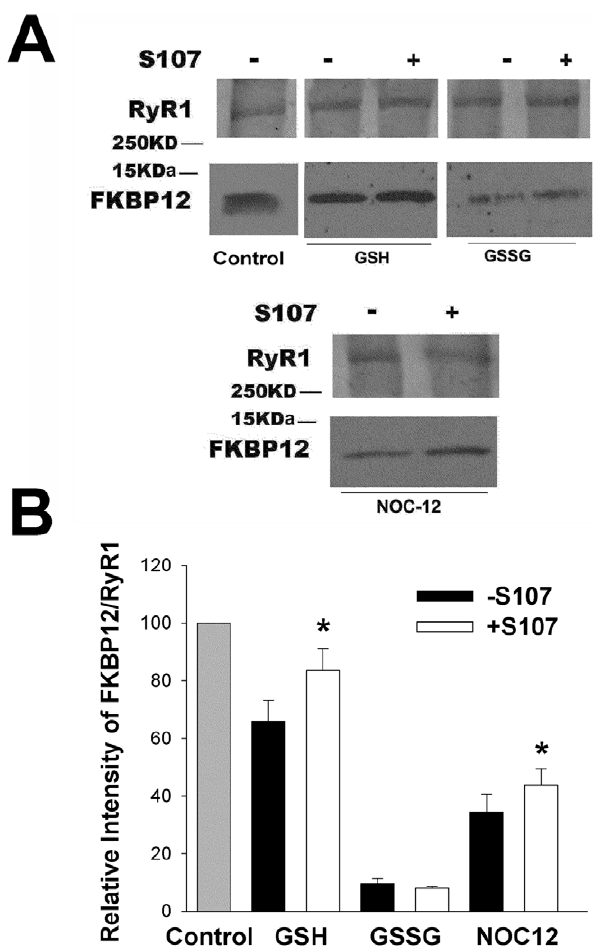
Figure 6. Effects of S107 on FKBP12 binding to RyR1. (A) Immunoblots of RyR1 and FKBP12. SR vesicles depleted of FKBP12 were incubated for 20 h at 24 u C in 0.25 M KCl, 20 mM imidazole, pH 7.0, 7 m M free Ca 2 + , protease inhibitors and 10 nM FKBP12 without or with 44 m M S107 in the absence and presence of 5 mM GSH, 5 mM GSSG or 0.10 mM NOC12. SR vesicles not treated with FK506 and incubated without glutathione served as control. (B) SR vesicles not treated with FK506 served as control. Data are the mean of 5–7 experiments. *p , 0.05 compared to FKBP12-depleted vesicles incubated without S107 in the presence of GSH and NOC12, respectively, as determined by paired Student’s t-test.